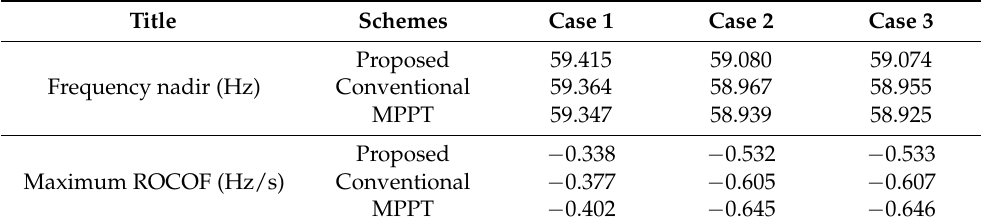
Table 1. Comparison indices including frequency nadirs and maximum ROCOFs for all